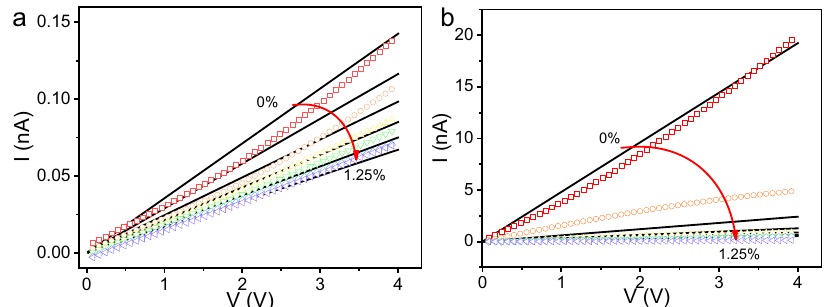
Fig. 3 Model of measured sensor currents. Calculated currents (black lines) and measured currents (colored symbols) for a selection of strains for a dark and b 365 nm laser illuminating